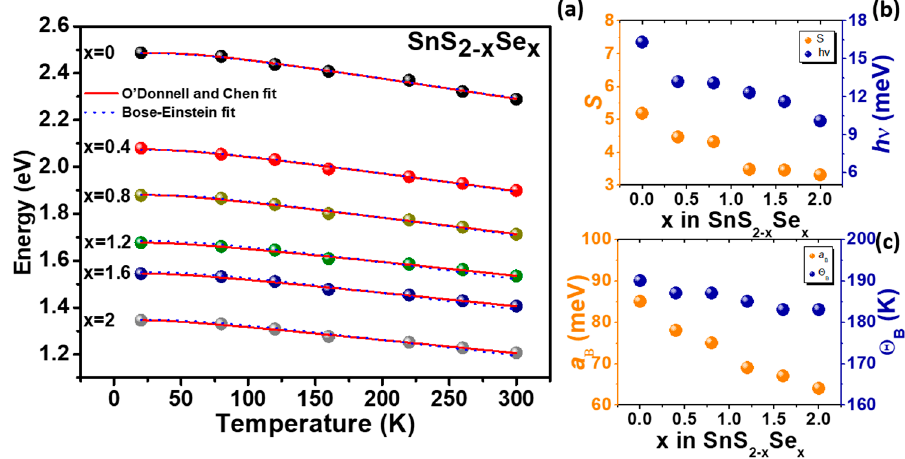
Figure 6. ( a ) The temperature dependence of the excitonic transition energies of SnS 2-x Se x layered crystals. The solid curves are least-squares fits to Equation (3) and the dashed curves are least-squares fits to Equation (4). ( b , c ) The parameters obtained from Equations (3) and (4) that describe the temperature variation of SnS 2-x Se x layered crystals were also plotted.